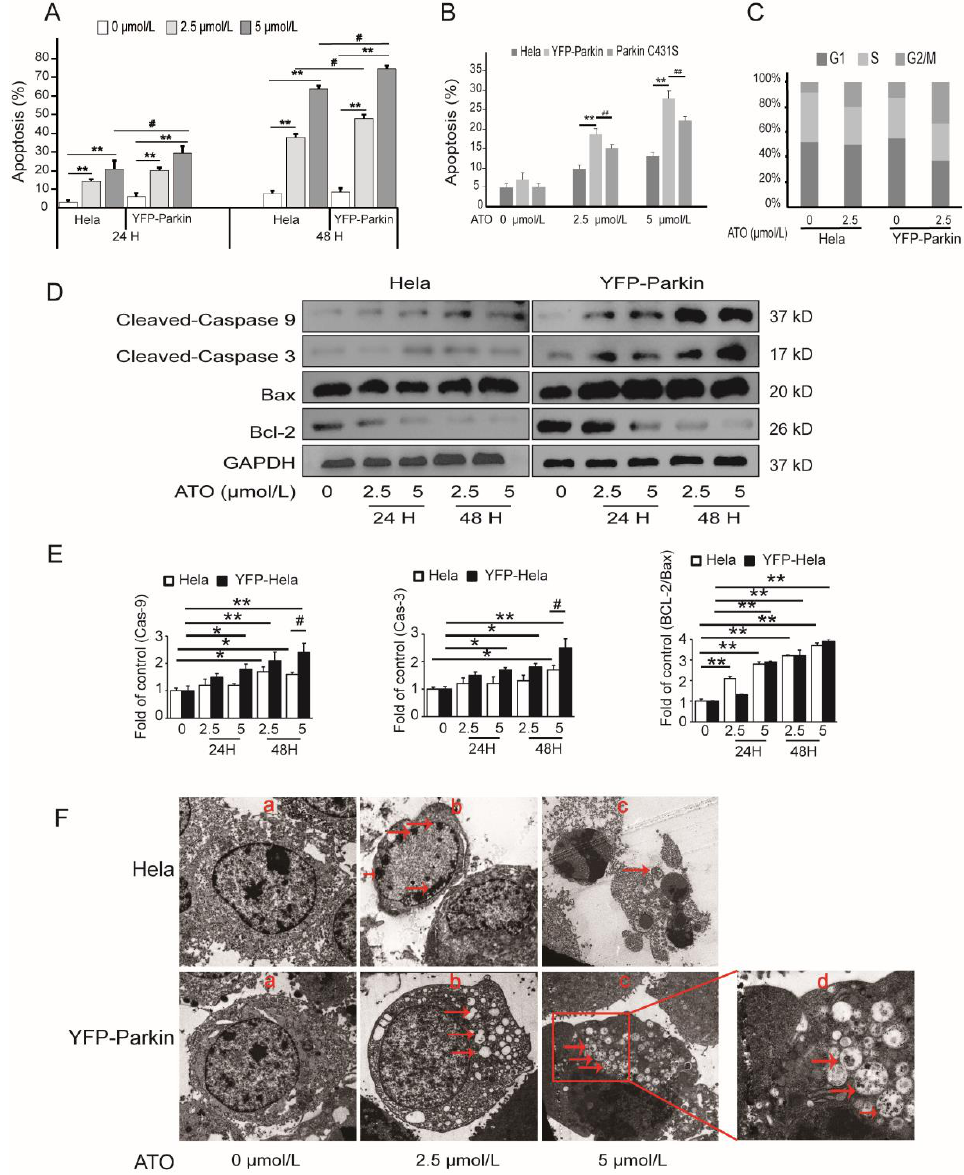
Figure 2. ATO induces the apoptosis of HeLa cells. ( A ) The apoptotic rate. ( B ) Parkin C431S rescued the apoptosis rate after ATO treatment for 24 h. ( C ) The percentage of cells in each phase of the cell cycle was analyzed after ATO treatment for 24 h by flow cytometry. ( D ) Western blot analysis of Cleaved-Caspase-3, Cleaved-Caspase-9, Bax, and Bcl-2 expression. ( E ) Quantification of D. ( F ) Morphology of apoptosis and autophagy was observed under a transmission electron microscope after ATO treatment for 24 h (a, b and c 5000×; d 15,000×). The arrowhead ( ↓ ) indicates the chromatin condensation, apoptotic bodies, autophagic vacuoles and mitophagosomes in apoptotic cells. The histograms represent the mean ± SD of triplicate experiments. * p < 0.05 vs. 0 µmol/L group, ** p < 0.01 vs. 0 µmol/L group, # p <0.05 vs. without Parkin group; ## p <0.01 vs. without Parkin group; GAPDH served as an internal control.